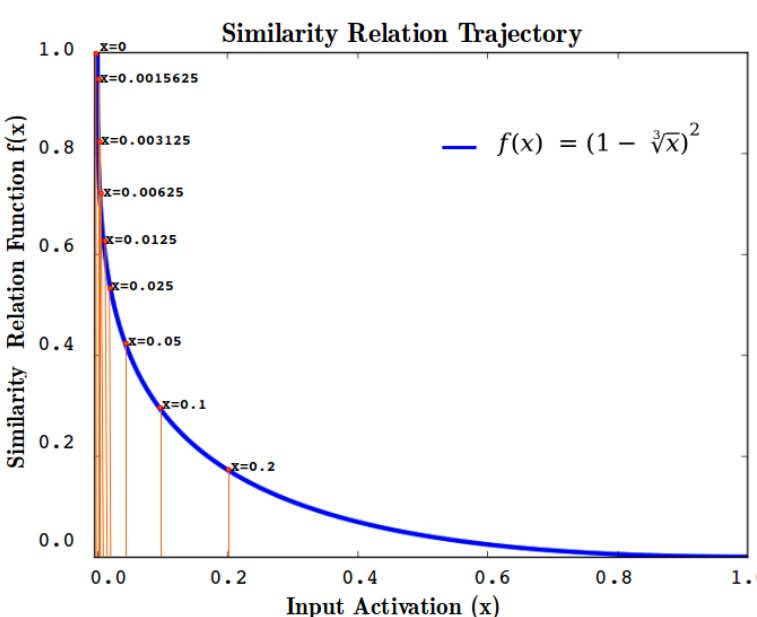
Figure 5. Plot of Similarity Translation Function with respect to varying input values in range [ 0,1 ]